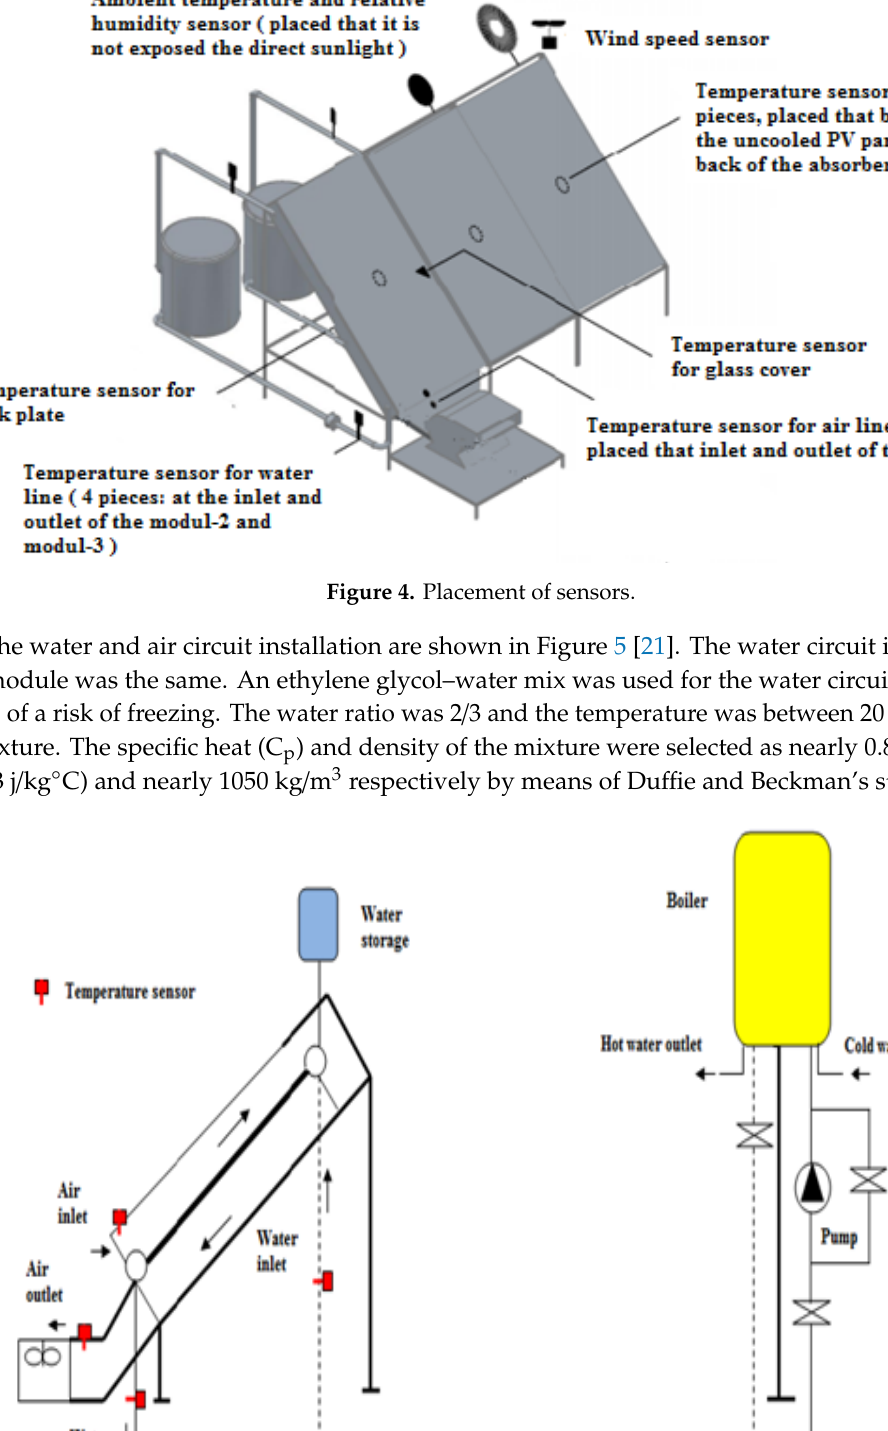
Figure 3. General view of experimental set up.